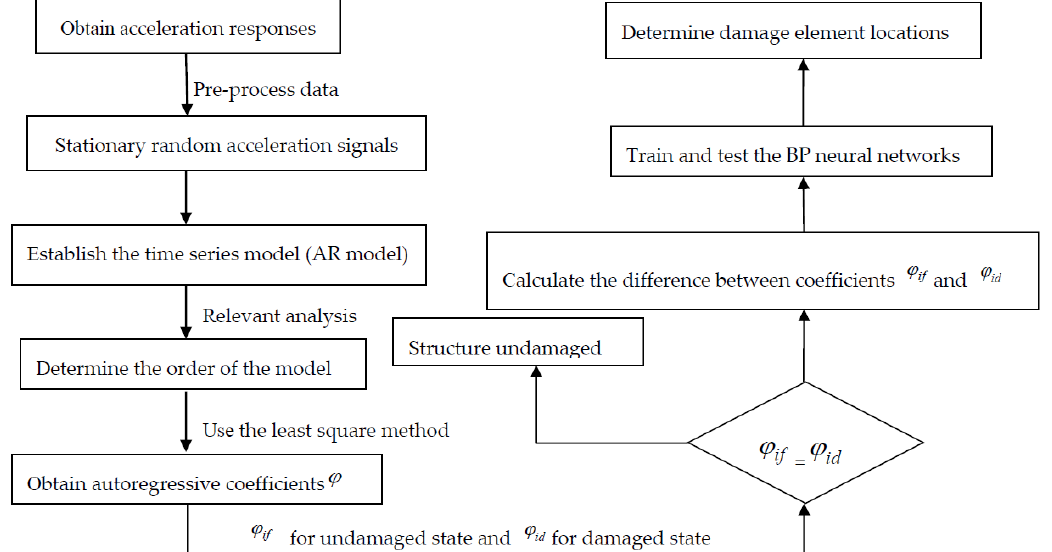
Figure 2. Flowchart of the proposed damage detection method.